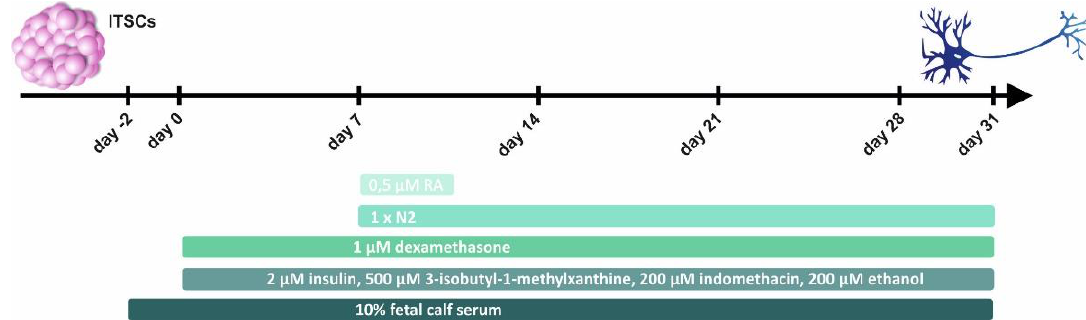
Figure 3. Illustration of the glutamatergic neuronal differentiation from inferior turbinate stem cells (ITSCs). Generation of ITSC-derived neurons for investigation of the neuroprotective effects of human plasma against oxidative stress was achieved by 31 days of neuronal differentiation. ITSCs: inferior turbinate stem cells; RA: retinoic acid.